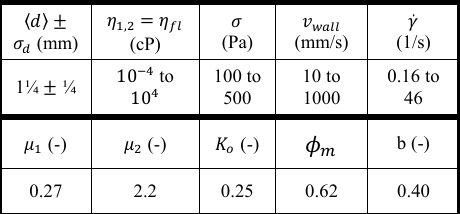
Table 2. Simulation input parameters (along with particle properties in Table 1) and fit parameters for data in Fig. 5.